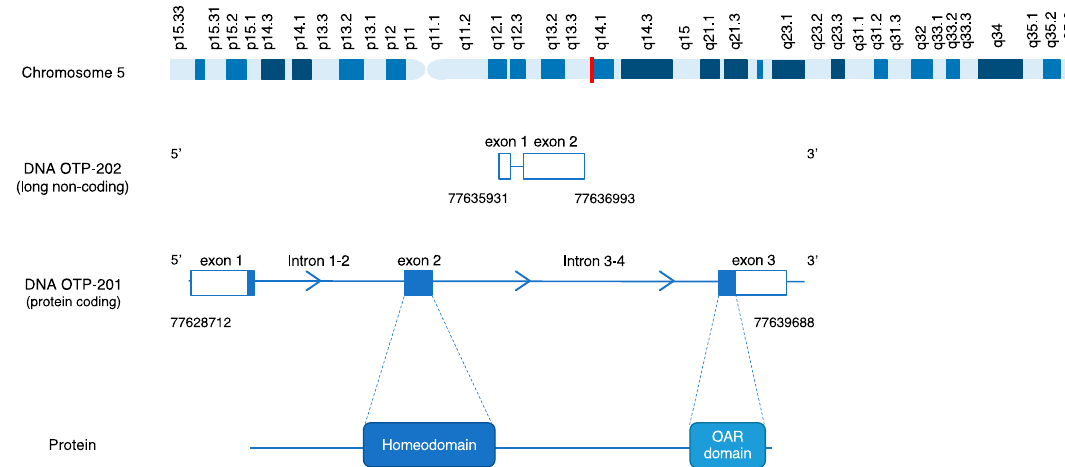
Figure 2. Schematic representation of the OTP gene. The chromosome row represents the genomic location of OTP (Red, 5q14.1), the DNA rows represent the gene composition with the genomic coordinates of both the protein coding transcript and the processed transcript, and the protein row represents the translated protein domains within the gene.